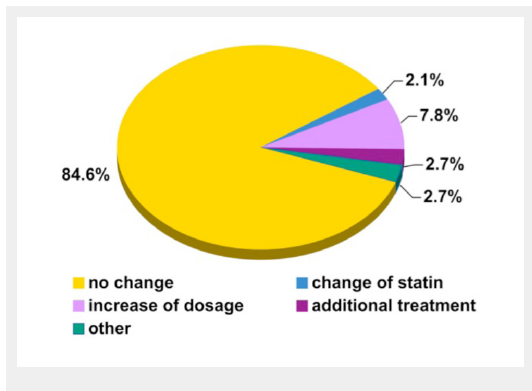
Change of lipid modifying treatment based on the laboratory results from the 473 patients included in the final